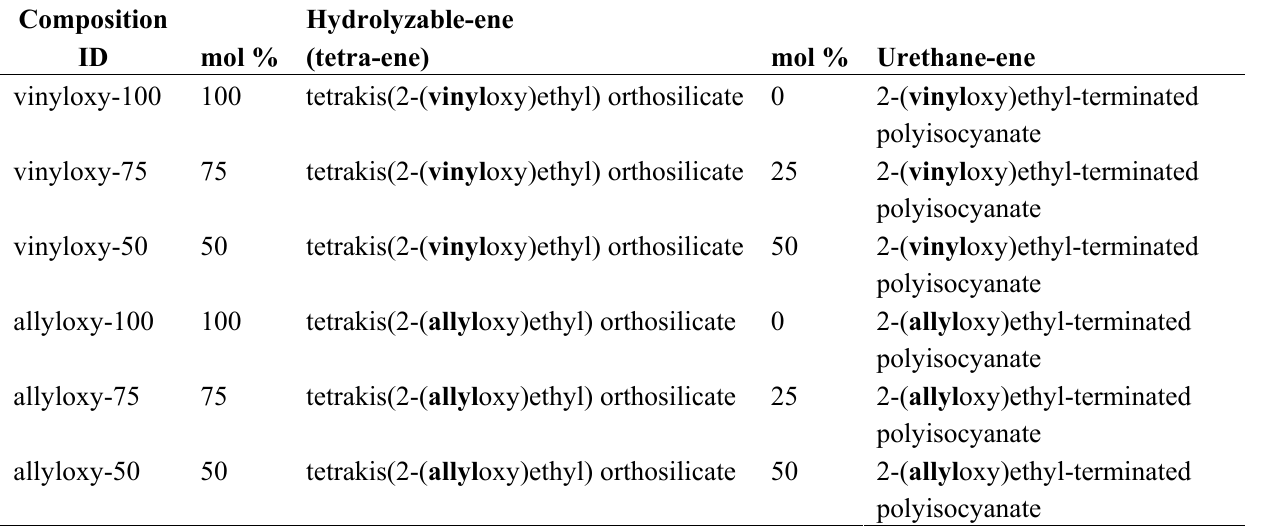
Table 1. Thiol-ene network compositions, describing the relative percents of tetra-ene and urethane segment used in the overall 1:1 thiol-ene matrix polymer